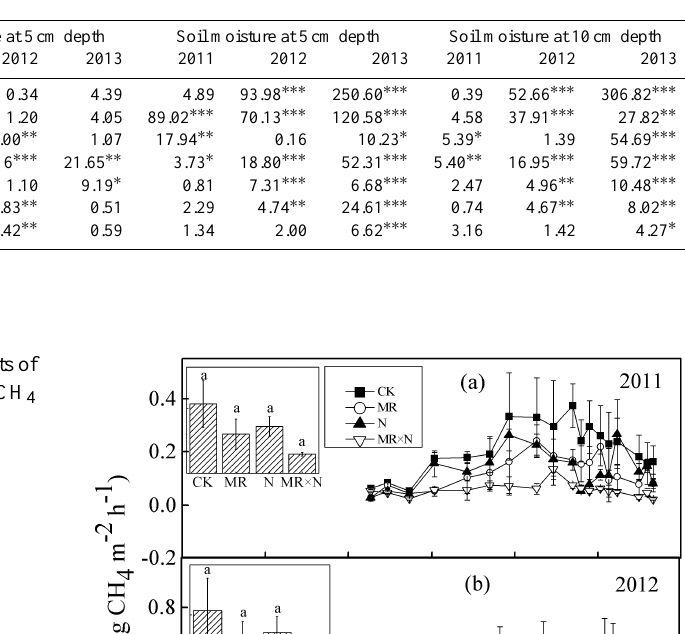
Table 1. Results ( F values) of repeated measures ANOVAs on the effects of N addition (N), moss removal (MR), sample times and their 10cm depth.